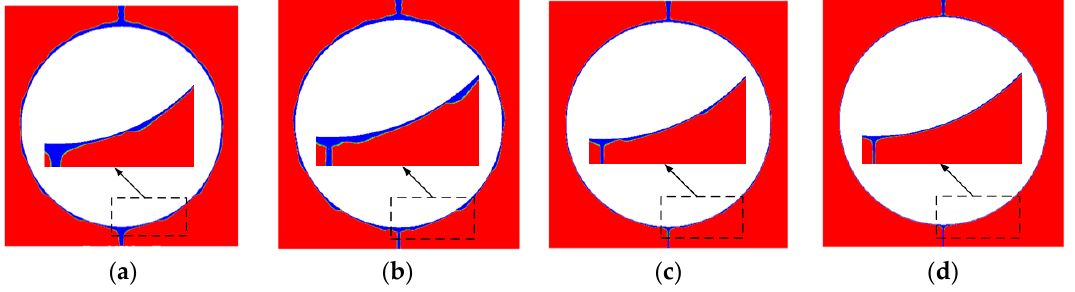
Figure 15. Film distribution on the horizontal tube under different fluids: ( a ) water; ( b ) seawater; ( c ) R290; and ( d ) liquid oxygen.